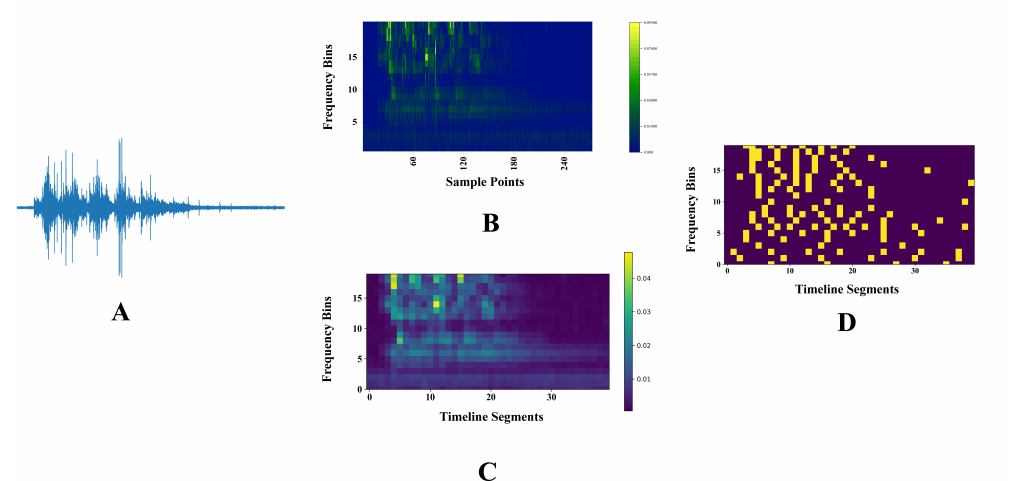
Figure 5. We choose ’horn’ to illustrate the Sigma-Delta audio encoding process. ( A ) The time-domain plot of the horn. ( B ) CQT is employed to obtain the spectrogram. The sampling rate is 48 kHz, and the number of samples between consecutive frames is 128. ( C ) To reduce the scale of the spectrogram and the number of spiking neurons in the first layer of the full-connected SNNs, each spectrogram of the subband is divided into specified timeline segments, with the points in each segment being averaged. ( D ) Encode the scaled spectrogram using SDE, noting that each SDE encodes only one row of data. Table 1. Parameters set for the RWCP dataset Network